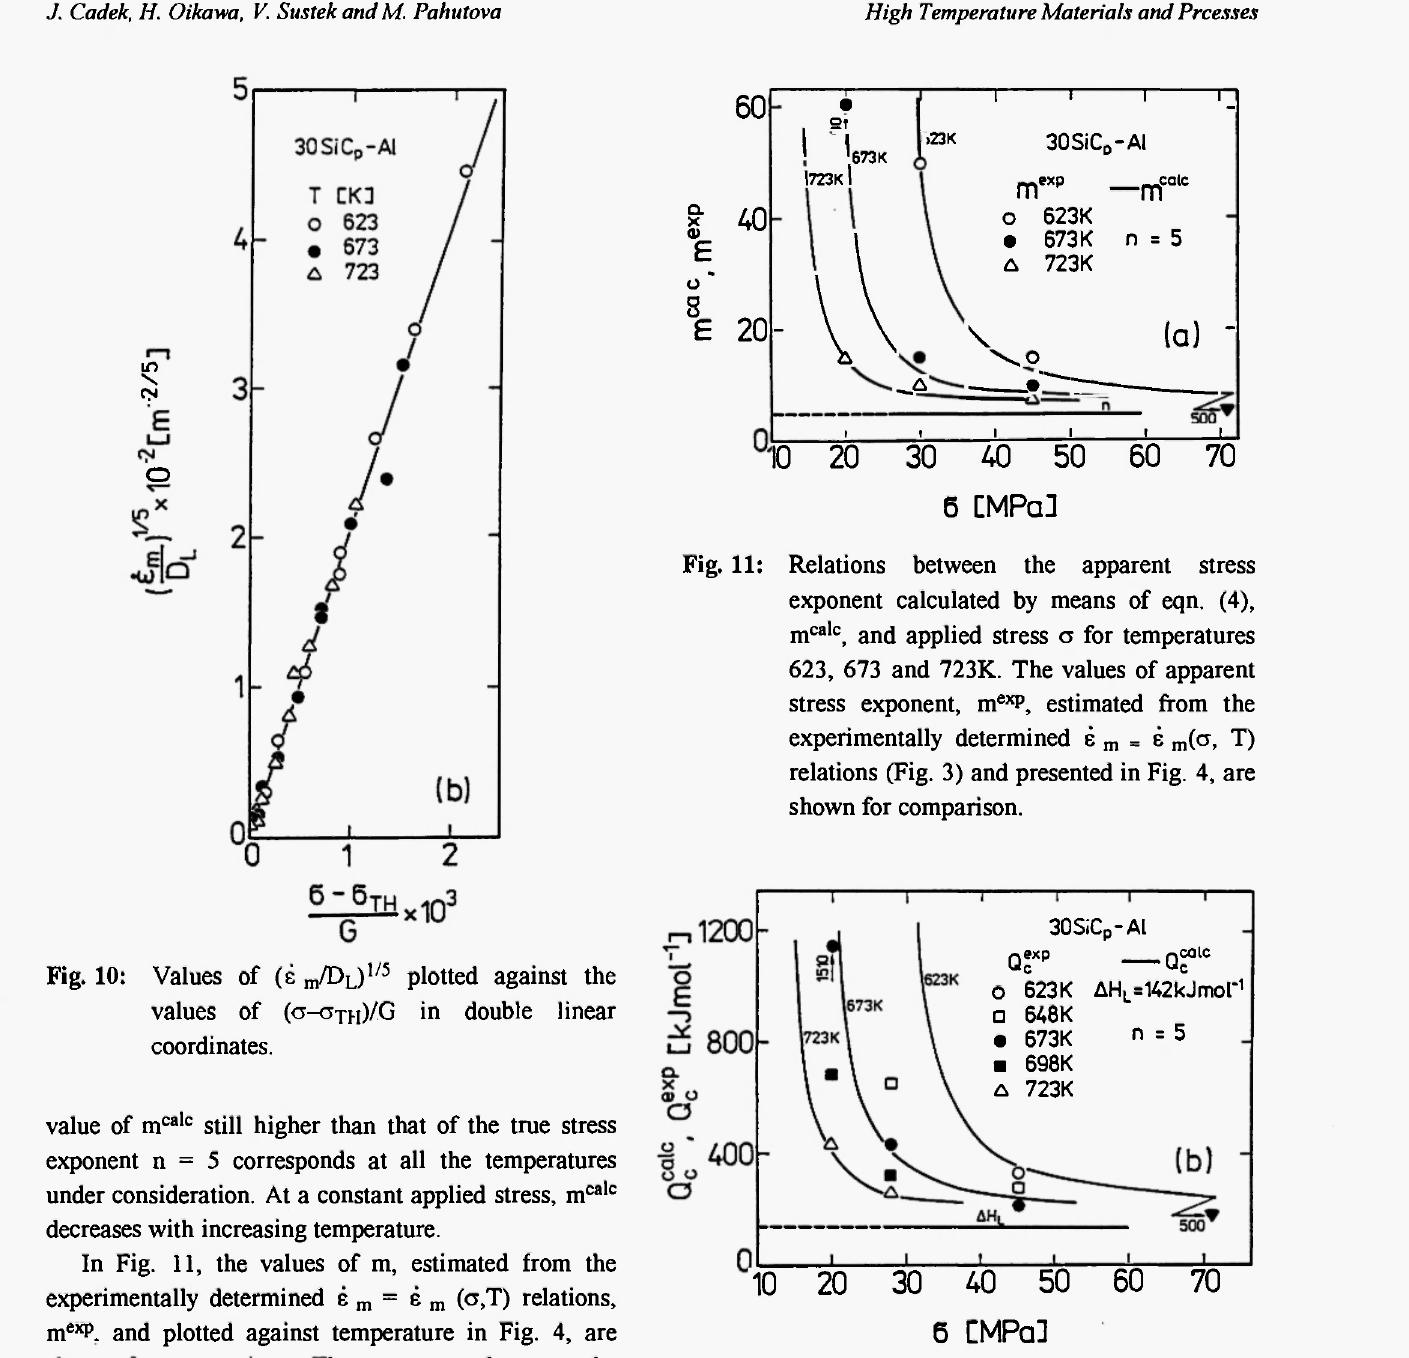
Fig. 12: Relations between the apparent activation energy of creep calculated by means of eqn. (5), Qg ,and applied stress σ for tem- peratures 623, 673 and 723K. The values of Q®^ estimated from the experimentally determined έ = έ (σ, Τ) relations and m m presented in Fig. 6 are shown for comparison.